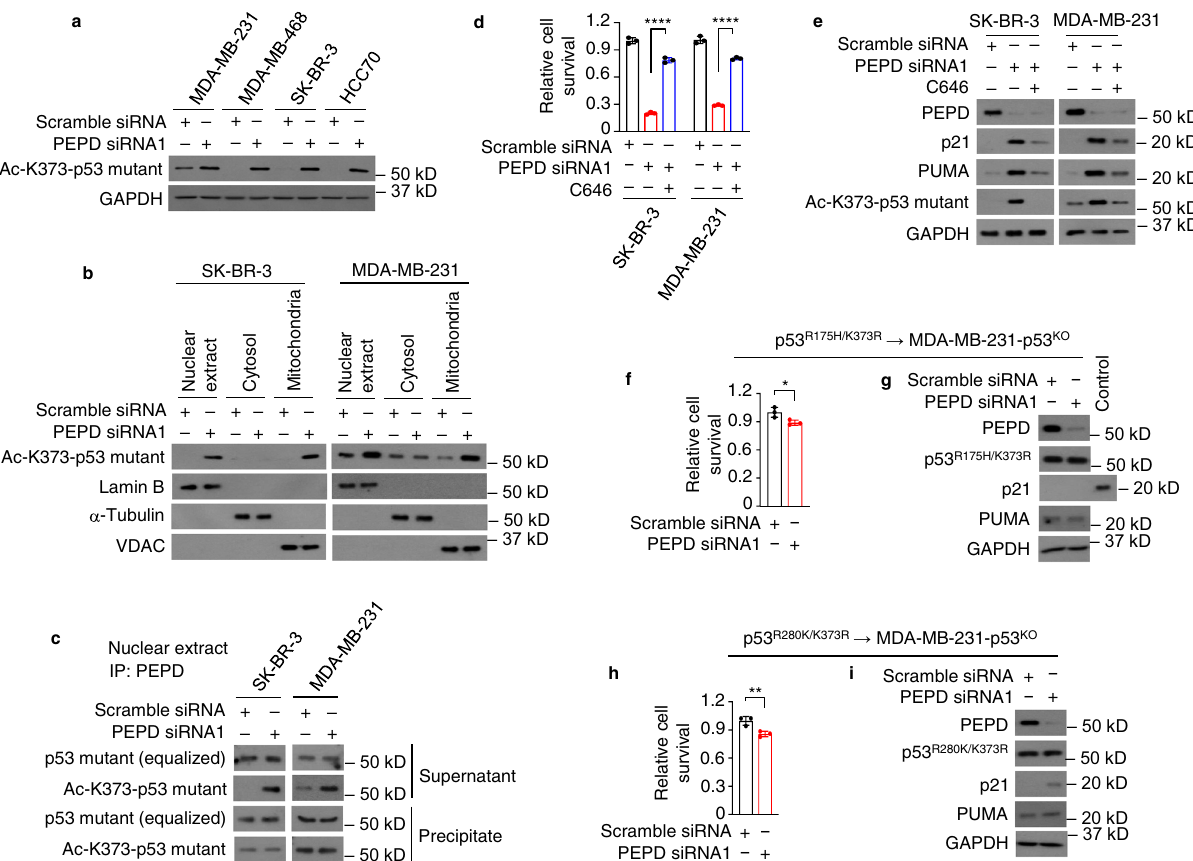
Fig. 7 K373 acetylation is essential for reactivation of p53 mutants. a, b Cells were treated by siRNA (10 nM) for 48 h. Ac-K373-p53 mutants in WCL in a and in subcellular fractions in b were analyzed by WB. c Cells were treated by siRNA (10 nM) for 48 h. PEPD-p53 mutant complexes were removed from the nuclear extracts by PEPD IP. The precipitate and the supernatant were analyzed by WB for p53 mutants and Ac-K373-p53 mutants. d , e Cells were treated by siRNA (10 nM) with or without C646 (8 μ M) for 72 h. Cell viability was measured by trypan blue assay in d . PEPD and other proteins in WCL were analyzed by WB in e . f – i MDA-MB-231 (p53 KO ) cells were transfected with p53 R175H/K373R or p53 R280K/K373R and 24 h later treated by siRNA (10 nM) for 96 h. The relatively long siRNA treatment time was for harvesting enough cells for analysis. Cell viability was measured by trypan blue assay in f and h . PEPD and other proteins in WCL were analyzed by WB in g and i . A p21-positive sample (WCL of SK-BR-3 cells treated by PEPD siRNA) was used as a control in g . GAPDH is a loading control in a , e , g , and i . α -Tubulin, lamin B and VDAC are loading controls and for ruling out cross contamination in b . The bar-dot plots in d , f , and h show individual values and mean ± SD ( n = 3). * P < 0.05, ** P < 0.01, **** P < 0.0001, by paired two-tailed t